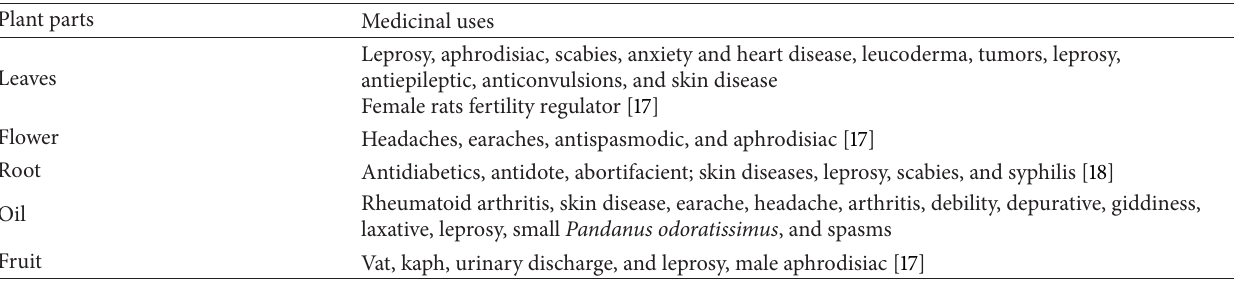
Table 6: Ethnomedicinal uses of P. odoratissimus